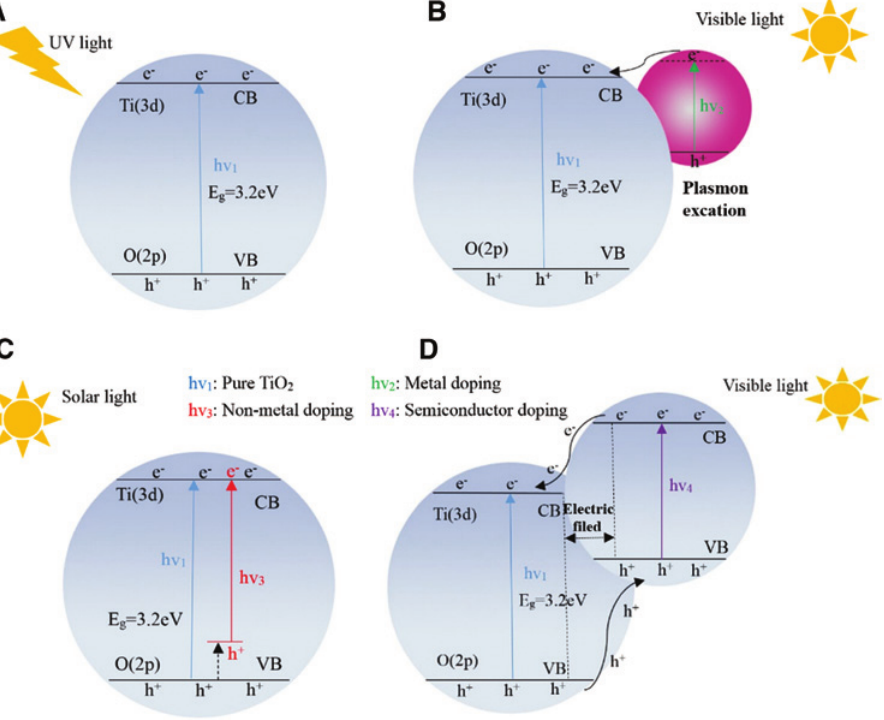
(A) and corresponding modification with metal 2